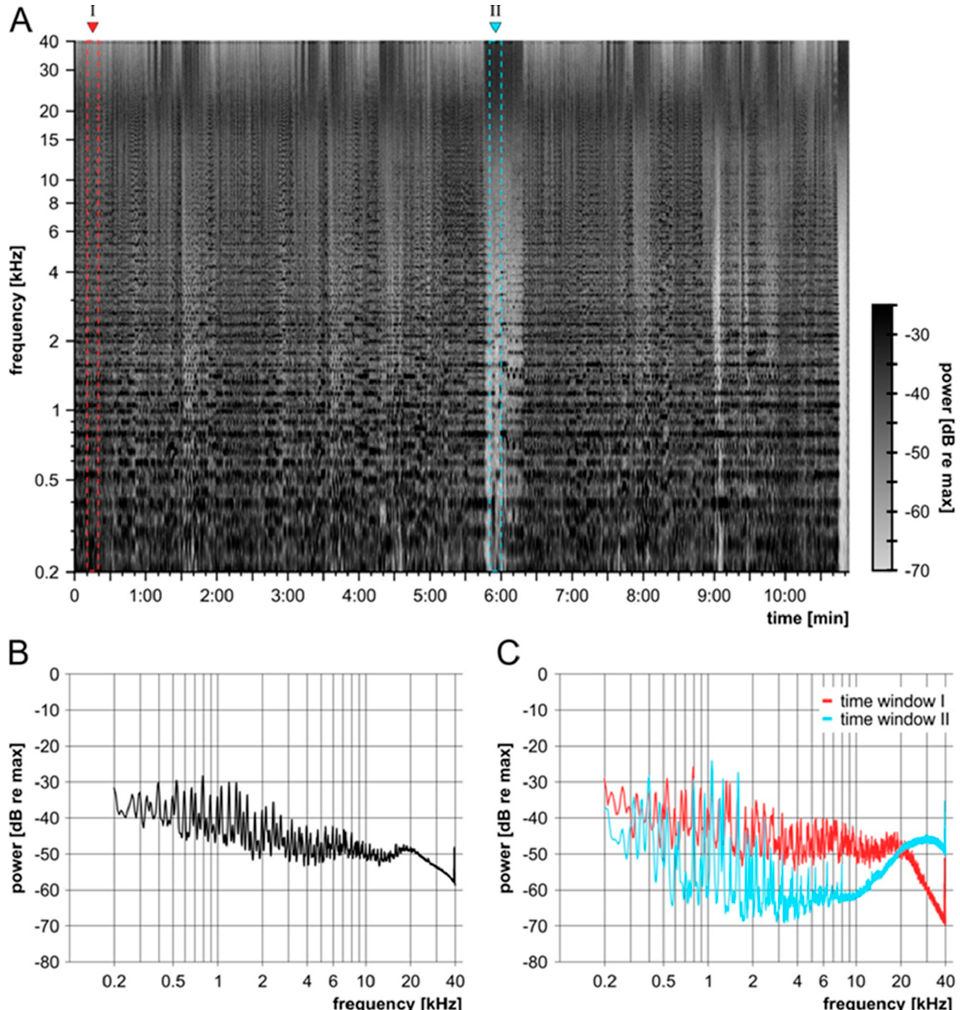
Figure 4. Description of the noise trauma. Characterization of the sound file for noise traumatization using Audacity ® , illustrating the applied frequency range and intensity. ( A ) Spectrogram of the sound file that contains frequencies from 80 Hz to 48 kHz. The colored fields (red, I; blue II) indicate the time windows that are analyzed in C. ( B ) Mean spectrum over the whole time (10 ′ 54 ″ ) of the sound file. The maximum range between frequencies is 30 dB. ( C ) Spectra of two time windows of 10´´. Time window I is located at the beginning (0 ′ 10 ″ ) and time window II in the middle (5 ′ 50 ″ ) of the signal. The spectrogram (A) was created using a Blackmann–Harris window with a width of 8192 samples. All spectra (B + C) were created using a Blackmann–Harris window with a width of 65,536 samples.